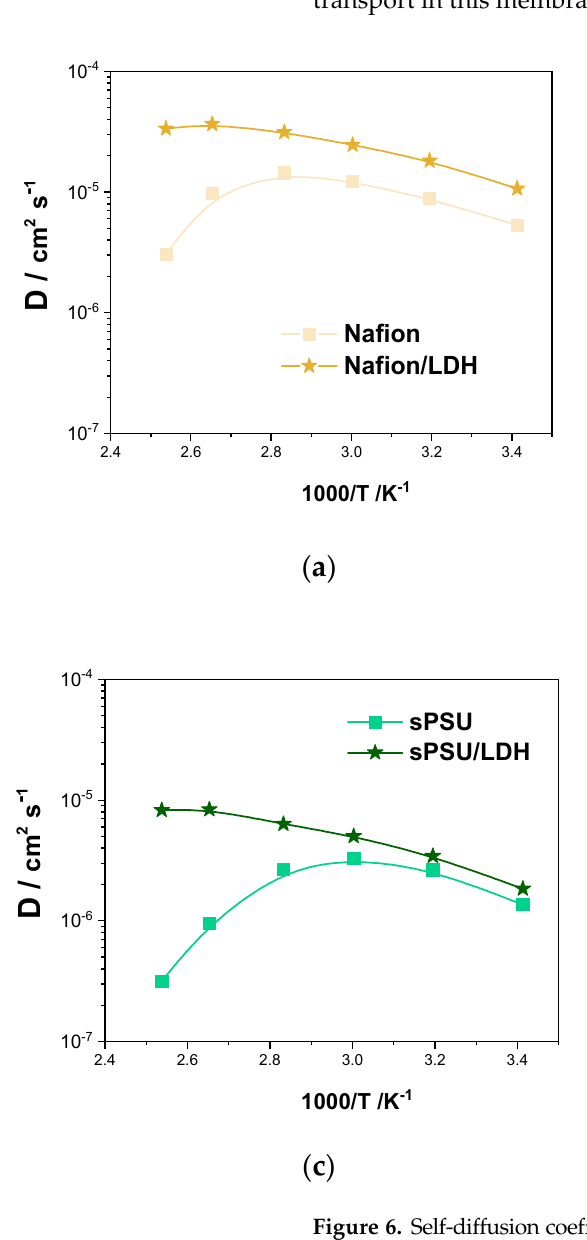
Figure 6. Self-diffusion coefficients and as a function of the temperature (from 20 °C to 120 °C) of the water confined in ( a ) Nafion and Nafion/LDH, ( b ) sPEEK and sPEEK/LDH and ( c ) sPSU and sPSU/LDH.